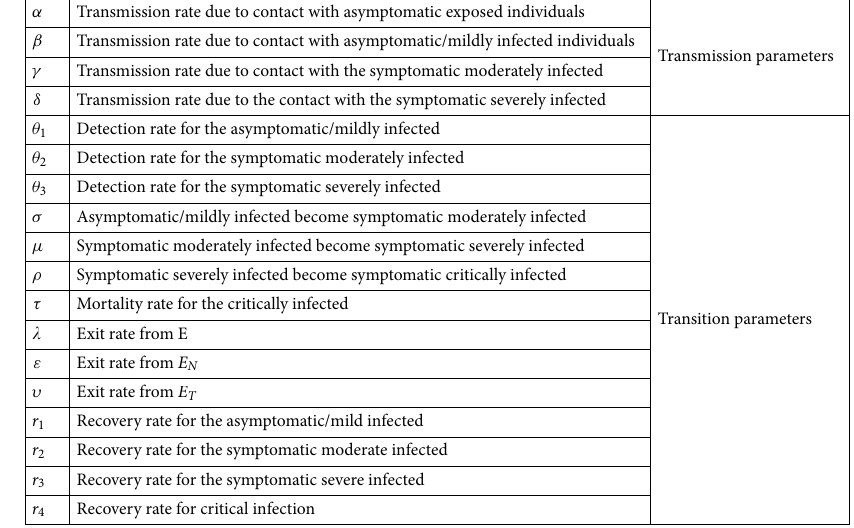
Table 1. Description of the